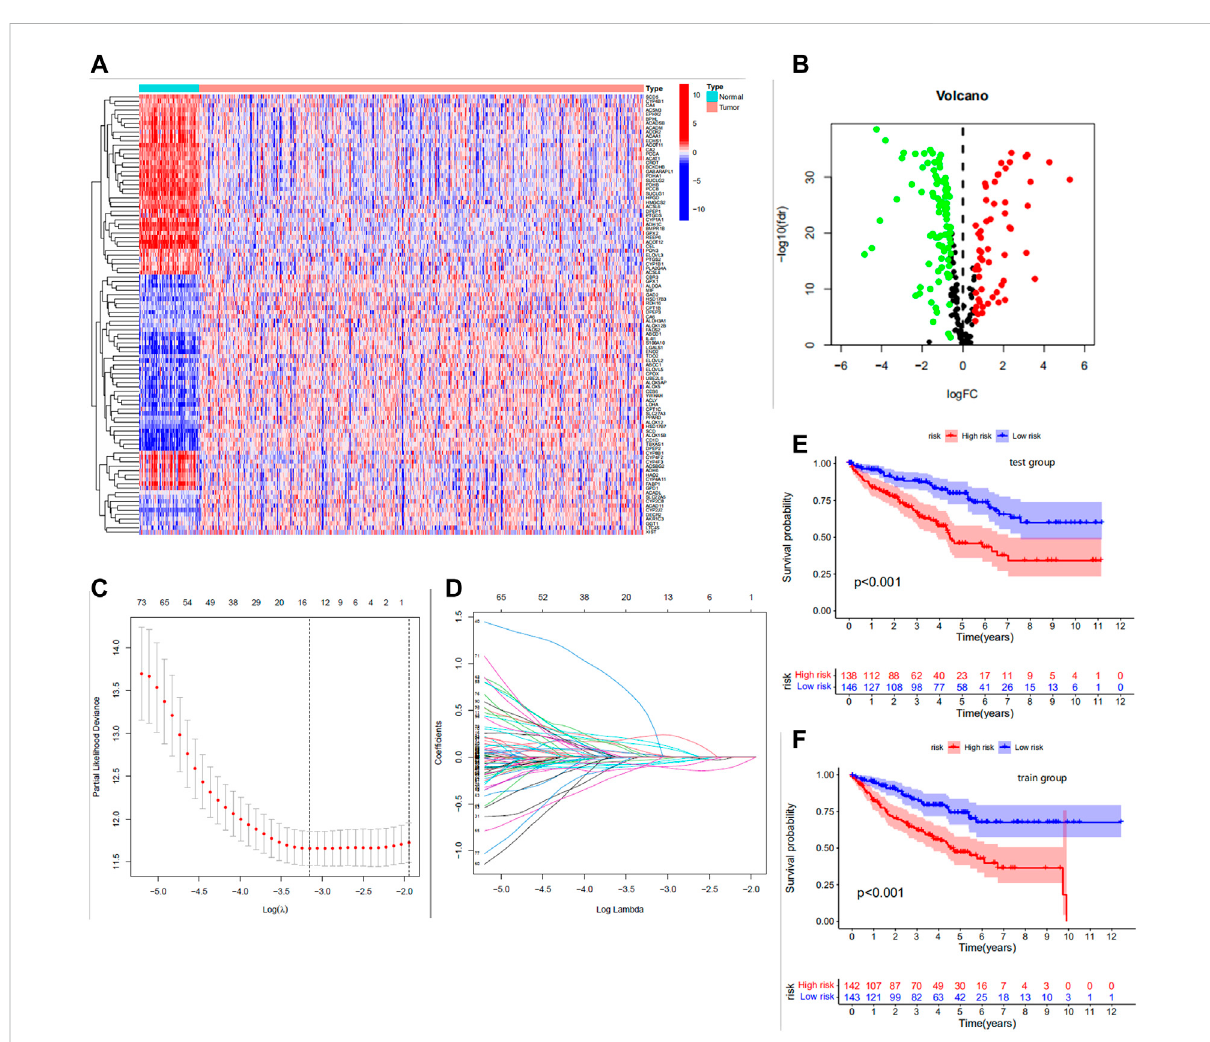
FIGURE 1 (A) Heat map of differential expression of the top 100 most signi fi cantly differentially expressed fatty acid metabolism genes. Red for high expression, blue for low expression. (B) Volcano plot of 151 differentially expressed genes. Red dots indicate upregulated genes, black dots indicate insigni fi cant differences, and green dots indicate downregulated genes. (C) Cross-validation was performed to select the minimum lambda value to obtain the modeled genes. (D) LASSO coef fi cient pro fi les of the 99 FRGS. (E,F) The Kaplan-Meier analysis in the test/train